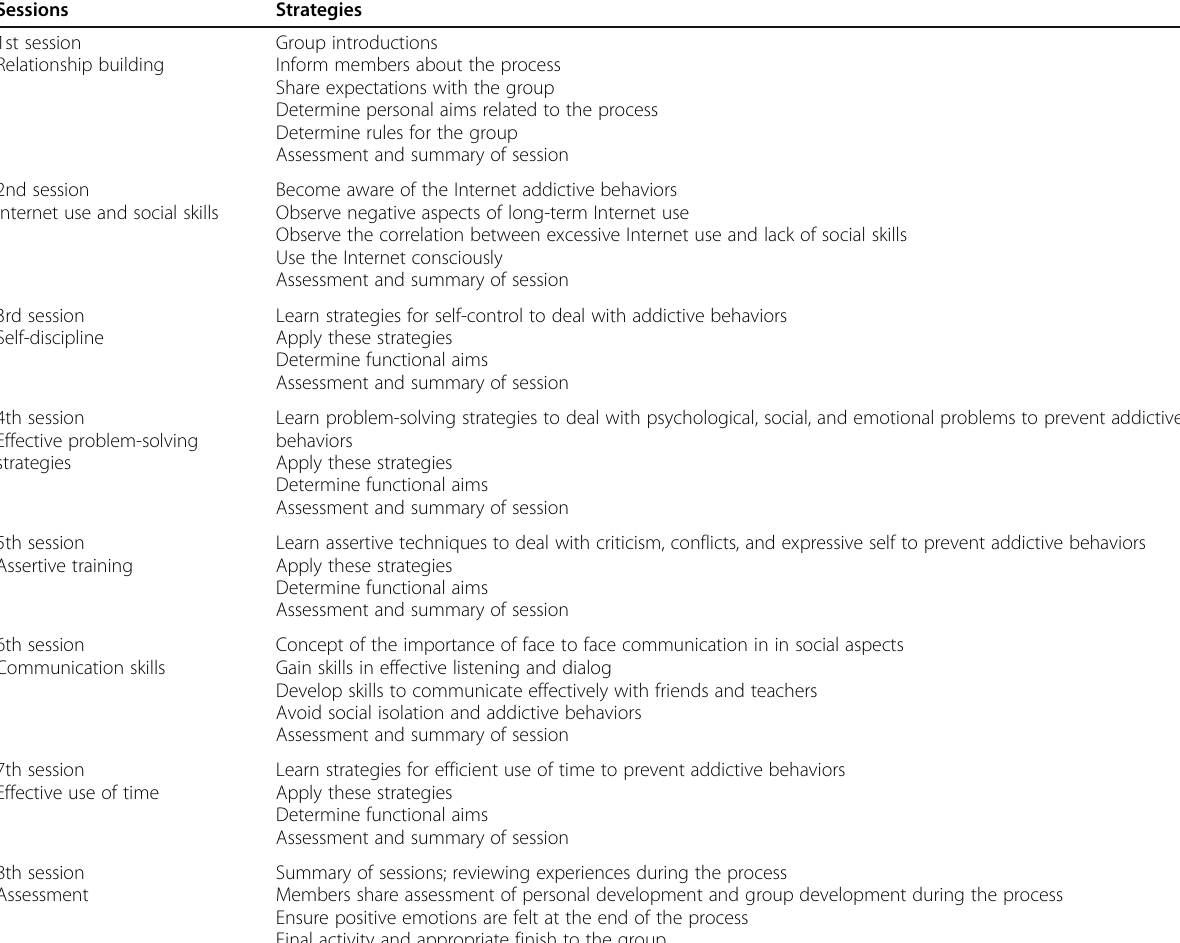
Table 1 Training-program sessions to increase social skills and reduce addictive behaviors